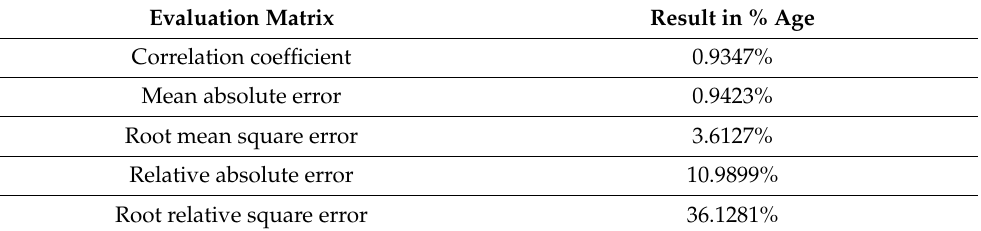
Figure 18. Analysis of the proposed horizontal eye gaze estimation model using the line plot. Table 7. Performance of CNN regression for the horizontal eye